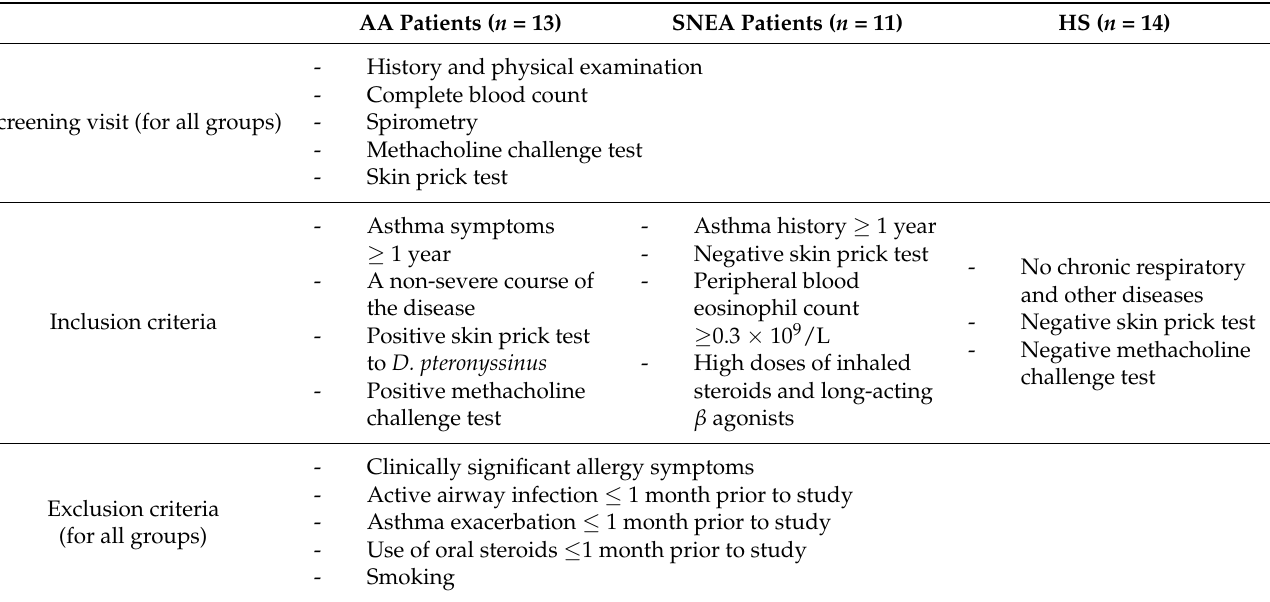
Table 1. Inclusion and exclusion criteria for the study population. AA Patients ( n =